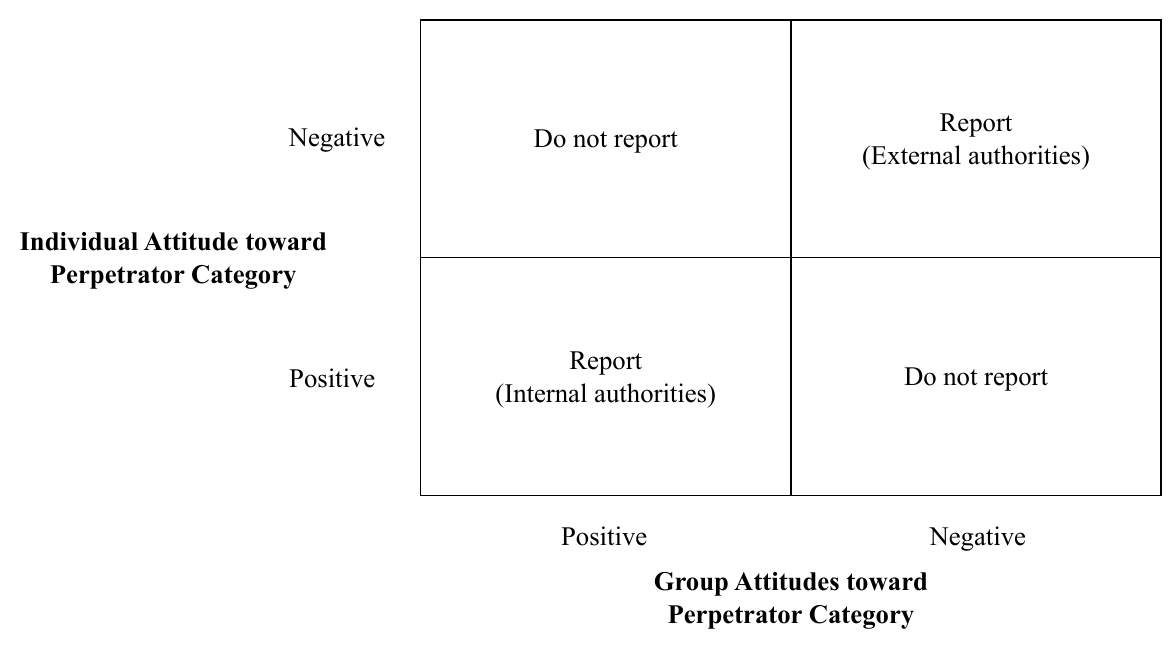
Figure 1: Model of reporting behavior based on individual and group attitudes toward a perpetrator’s salient